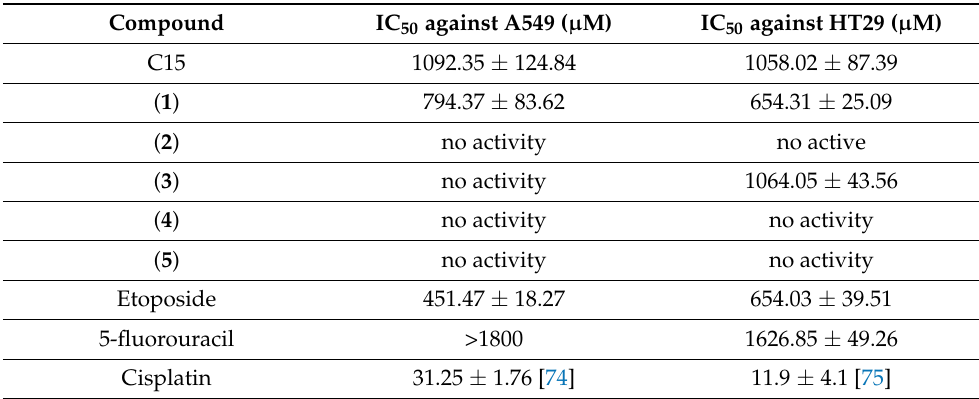
Table 3. In vitro cytotoxic activity of new compounds ( 1 )–( 5 ) and C15 on two cancer cell lines (A549 and